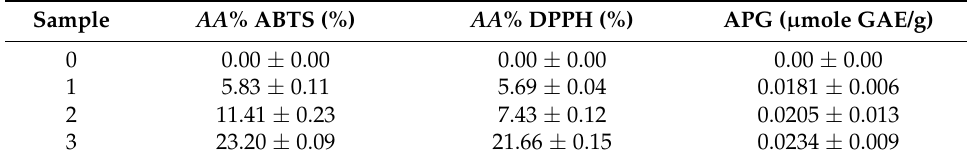
Table 3. The antioxidant activity determined by ABTS ( AA % ABTS) and DPPH ( AA % DPPH) methods and available phenolic groups (APG) of pure PLA and PLA/melanin modified films.